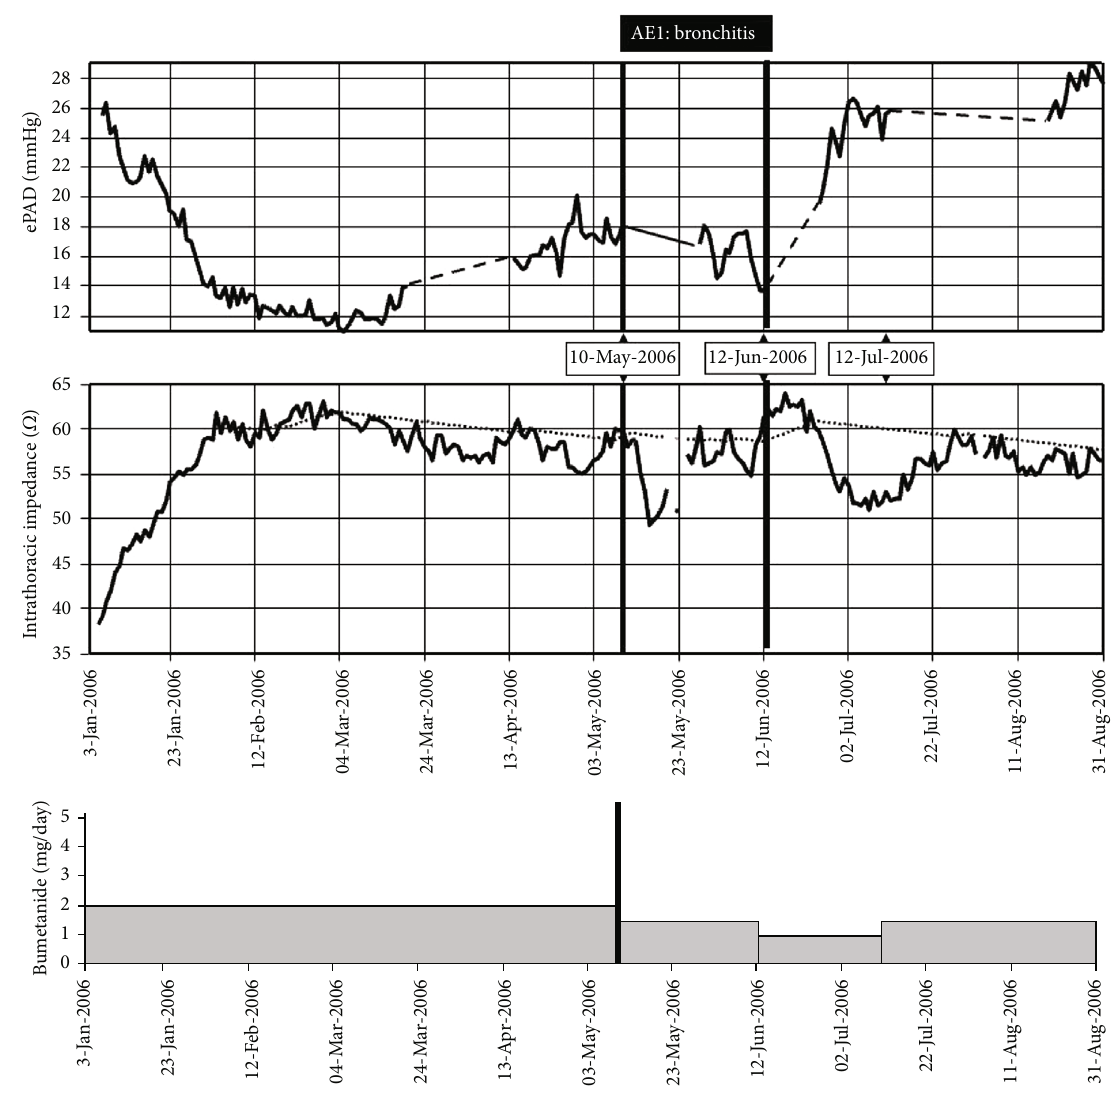
Figure 1: (a) Daily averaged estimated pulmonary artery diastolic pressure (ePAD). (b) Intrathoracic impedance ( Ω ) with reference line (dotted). (c) Diuretic dose (bumetanide, mg/day). AE: adverse event. Dashed lines indicate loss of long-term trend data because of remote patient hospitalization and